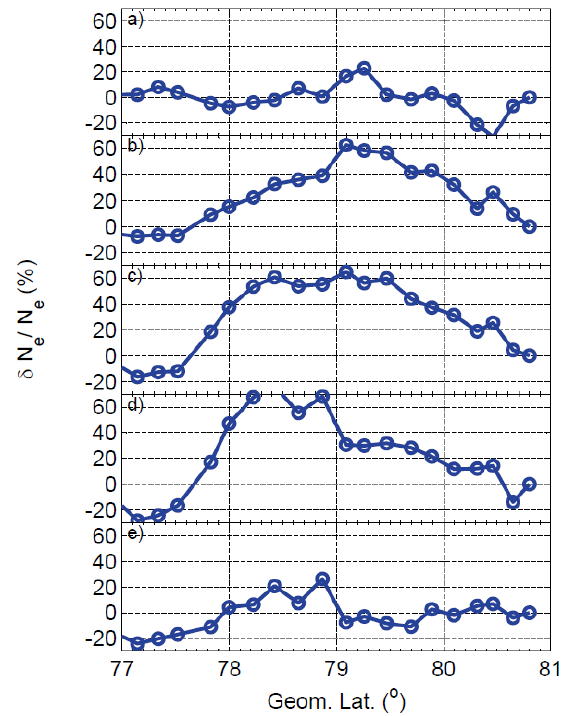
Figure 8. Spatial variations of electron density perturbations measured by the ESR 32m dish in dayside polar cap. From top to bottom, panels present relative electron density disturbances vs. geomagnetic latitude at selected intervals: (a) 1011UT; (b) 1024 UT; (c) 1031 UT; (d) 1048 UT and (e) 1106 UT.